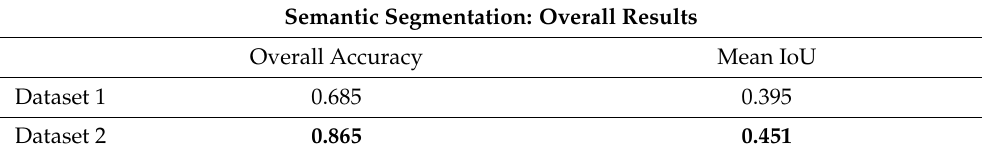
Table 5. Comparison of the overall accuracy and mean IoU of the semantic segmentation results using the PointNet++ architecture. Dataset 1 refers to the DALES Viewpoints Version 2 dataset using only the input points containing occlusions. Dataset 2 refers to the DALES Viewpoints Version 2, which includes the input points with occlusions, supplemented by our generated points.